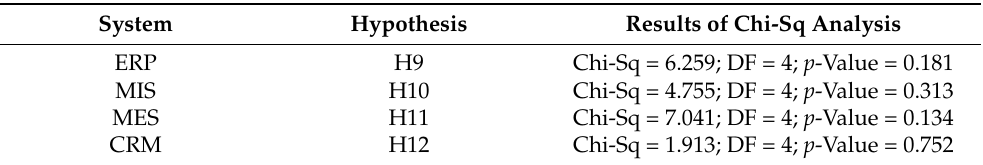
Table 4. Results of Chi-Sq analysis for ERP, MIS, MES, and CRM systems depending on production type (Continuous production, Large-scale production, Mid-series production, Small series production, Unit production).